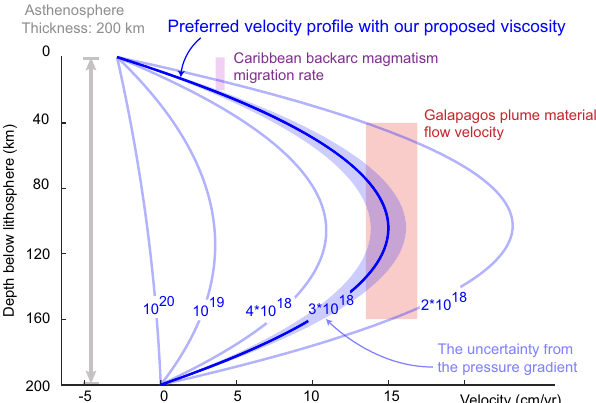
Fig. 4 Pro fi les of Caribbean asthenospheric fl ow velocities versus depth as a function of asthenospheric viscosity (see Eq. (1)). The thick blue line denotes the pro fi le corresponding to our preferred viscosity value of 3*10 18 Pa s. The blue-shaded area shows the uncertainty of the velocity pro fi le induced by the uncertainty in the pressure gradient. Colored boxes show independent estimates of fl ow velocity, constrained by the depth of melting and the migration rate of back-arc magmatism 26 (purple box) and by the current position of the leading edge of the Galapagos plume material which has been fl owing into the Caribbean since the opening of the slab window at ~8.5 Ma (red box). Pro fi les for alternative thickness values are reported in Supplementary Fig. 5.